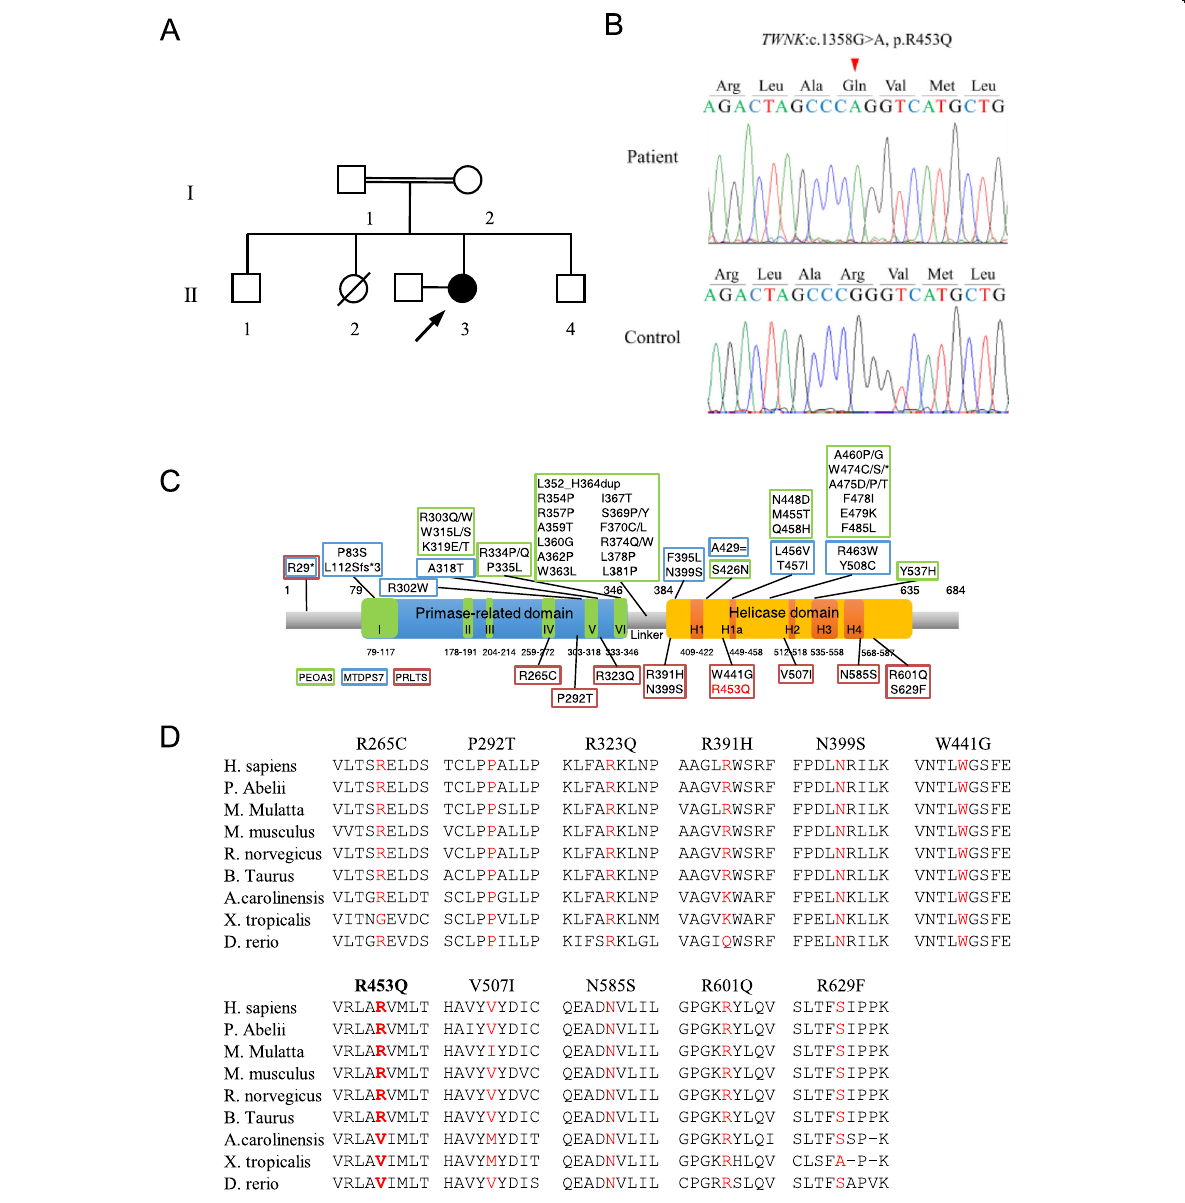
Fig. 1 Identification of the TWNK variant. a Family tree in this study. The filled circles indicate affected individuals, and the open circles and boxes indicate non-affected individuals. The proband is indicated by an arrow. b Sanger sequences of the TWNK variant in the patient and a control subject. c Domain architecture of Twinkle and previously reported variants for three phenotypes: dominant progressive external